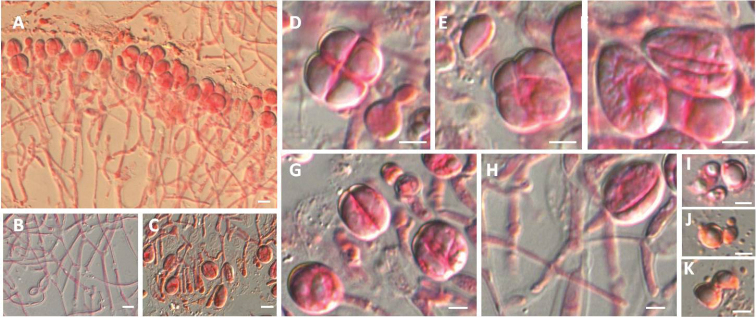
Microscopic structure of Tremellaerythrina (HMAS 255317). A Section through hymenium B Hyphae from context C Hyphidia with basidia of different developmental stages D–H Mature basidia I–K Basidiospres. Scale bars: 10 μm (A–C), 5 μm (D–K).